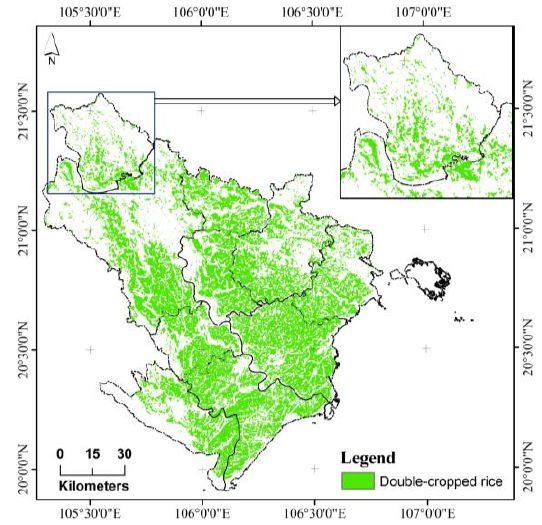
Figure 7. Rice crop map derived from five year time